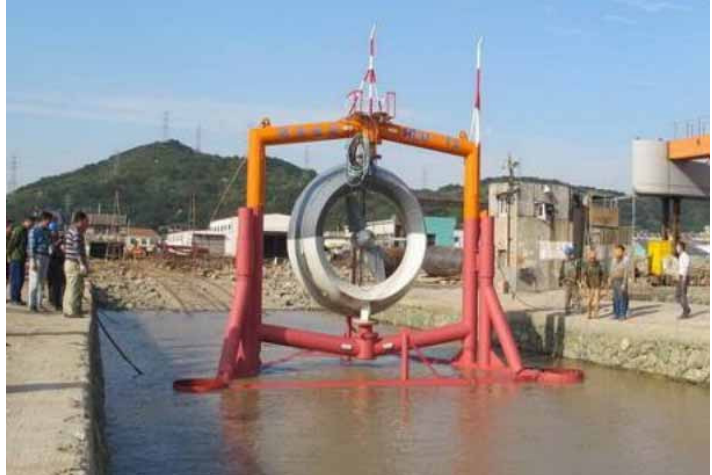
Figure 5. “Haiming I”—10kW submarine vertical-axis TCPGS. Reproduced from [4].